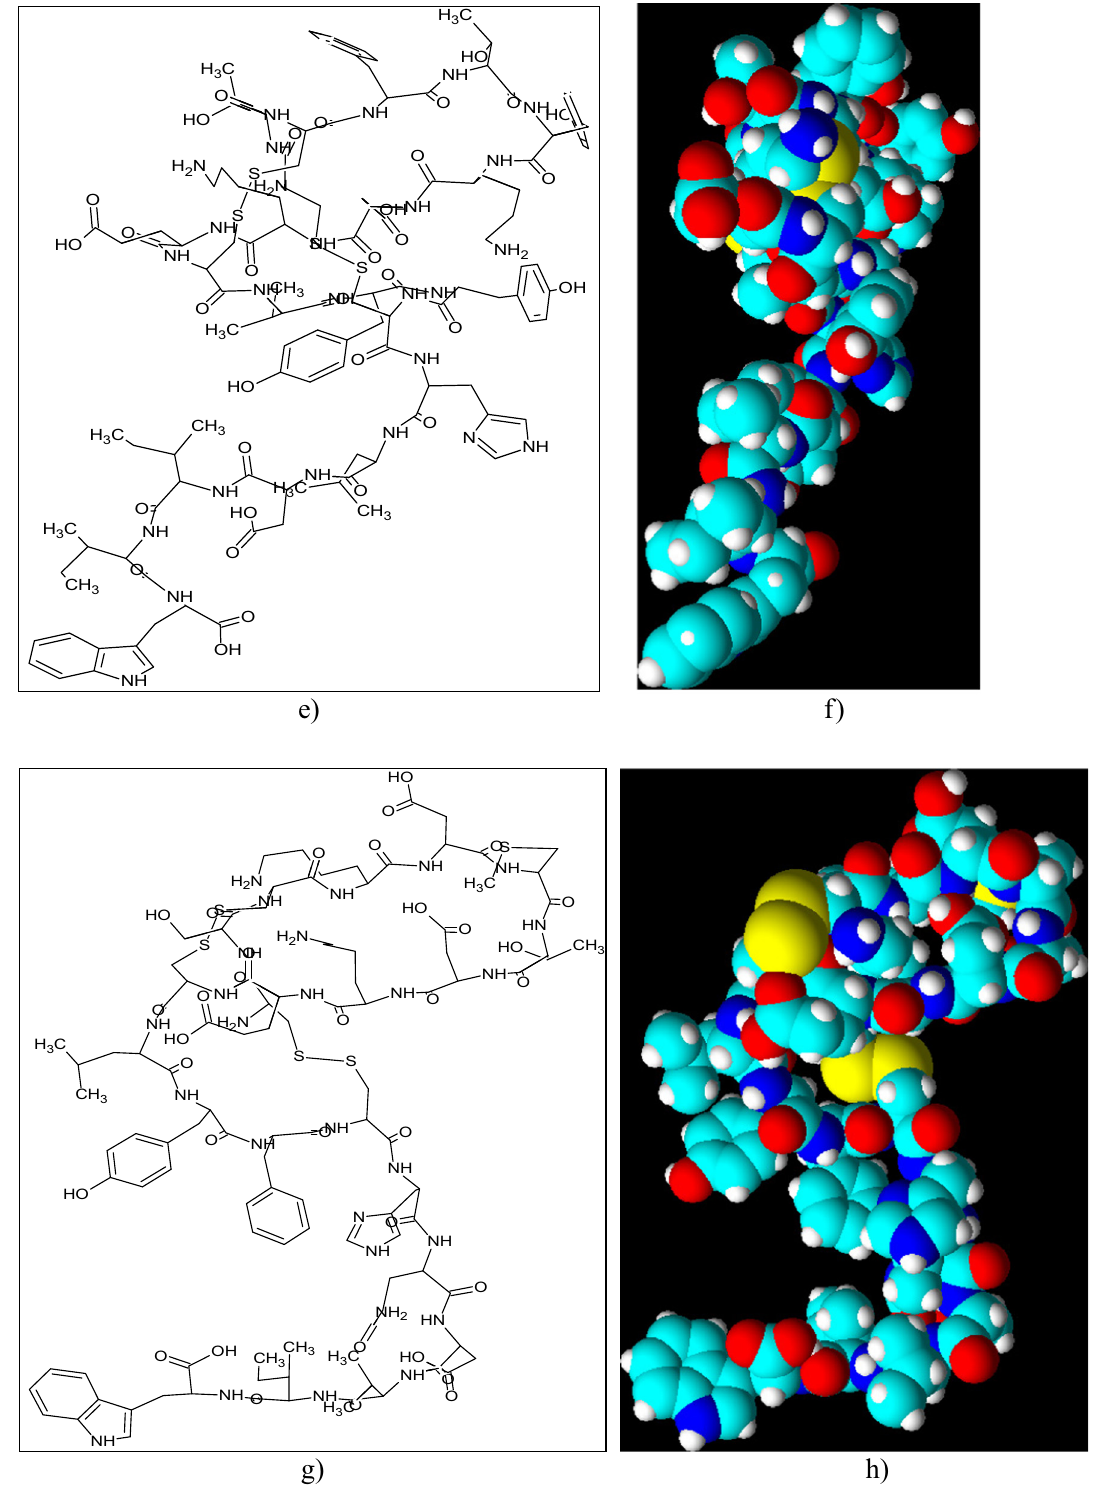
Figure 3: Structures of ETs and SRT - 6b; ( a ) ET - I and ( b ) ET - I space - fi lling model; ( c ) ET - II and ( d ) ET - II space - fi lling model; ( e ) ET - III and ( f ) ET - III space - fi lling model; ( g ) SRT - 6b and ( h ) ET - III space - fi lling model; all structures and models are minimum energy conformers. Structures are shown without explicit hydrogens, the space - fi lling models ’ explicit hydrogens are